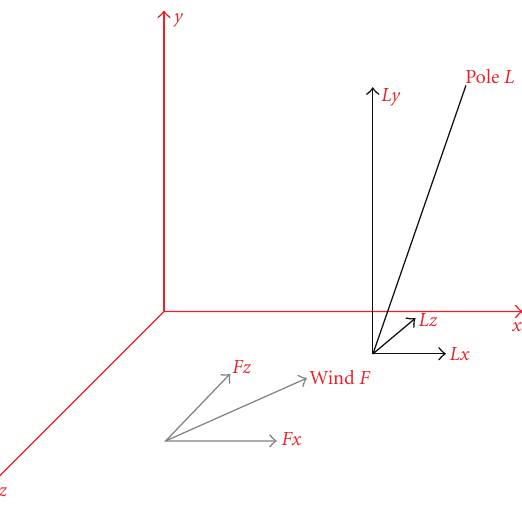
Figure 7: Wind decomposition and pole decomposition.